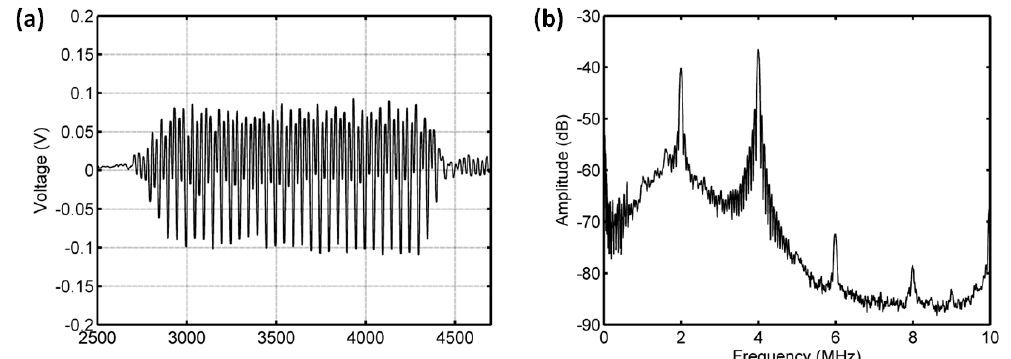
Figure 14. The measured scattering signals from microbubbles and the averaged power spectrum of 50 received signals. ( a ) A single received signal, ( b ) the averaged power spectrum. The driving frequency was 4 MHz, the acoustic pressure was 500 kPa, and the overpressure was 8 mmHg.